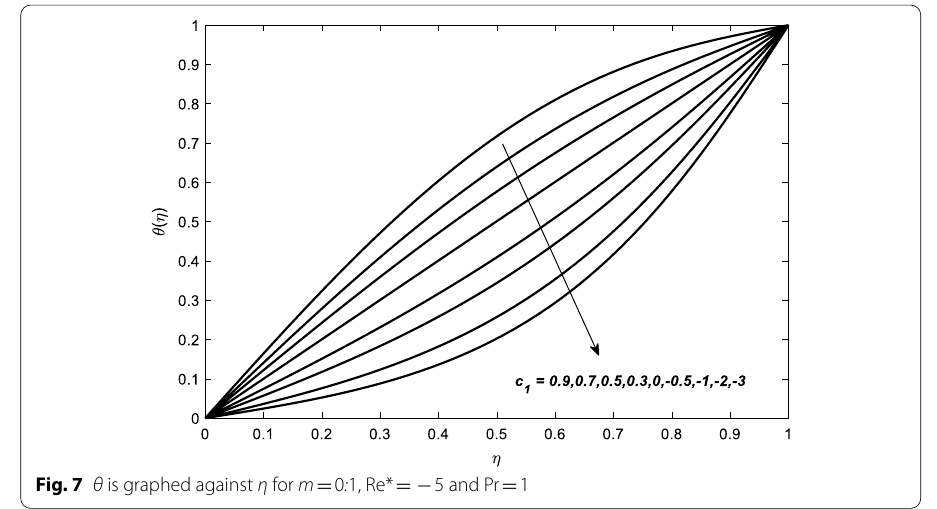
Fig. 7 θ is graphed against η for m